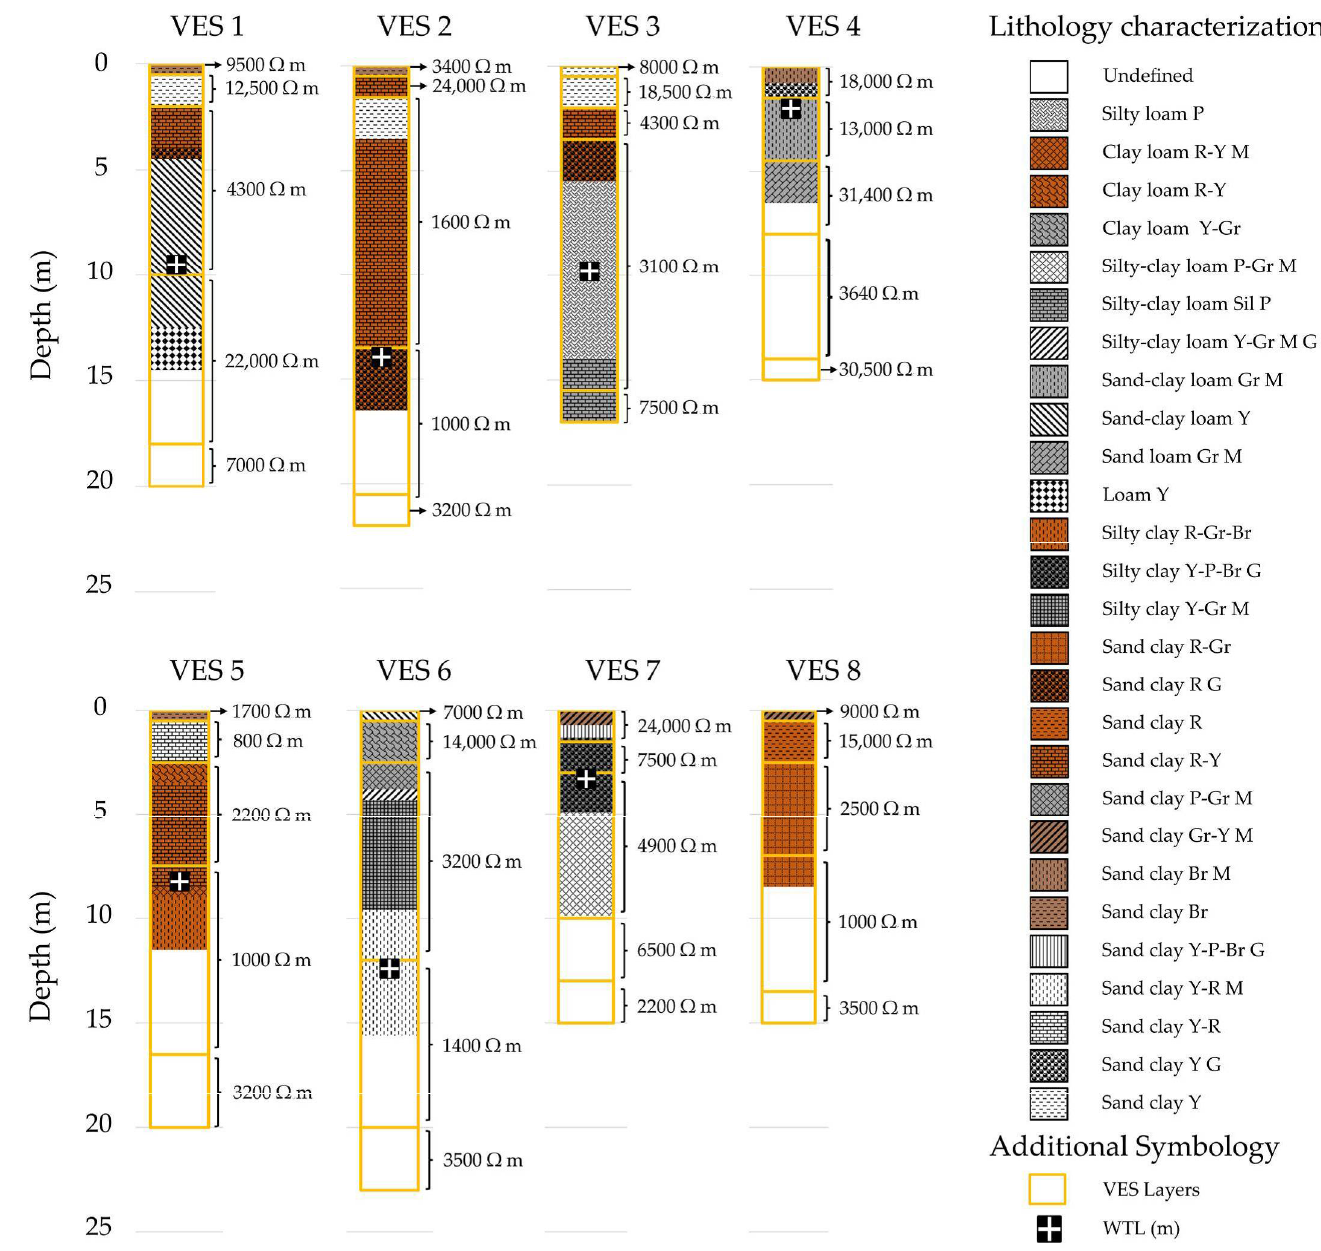
Figure 3. Geophysical-lithological models with inverted electrical resistivity and description of soil layers. M = mottled, G = gravel, R = red, Y = yellow, Br = brown, P = purple, Gr = grayish, WTL = water table level (m). There were no lithology data for VES 9.